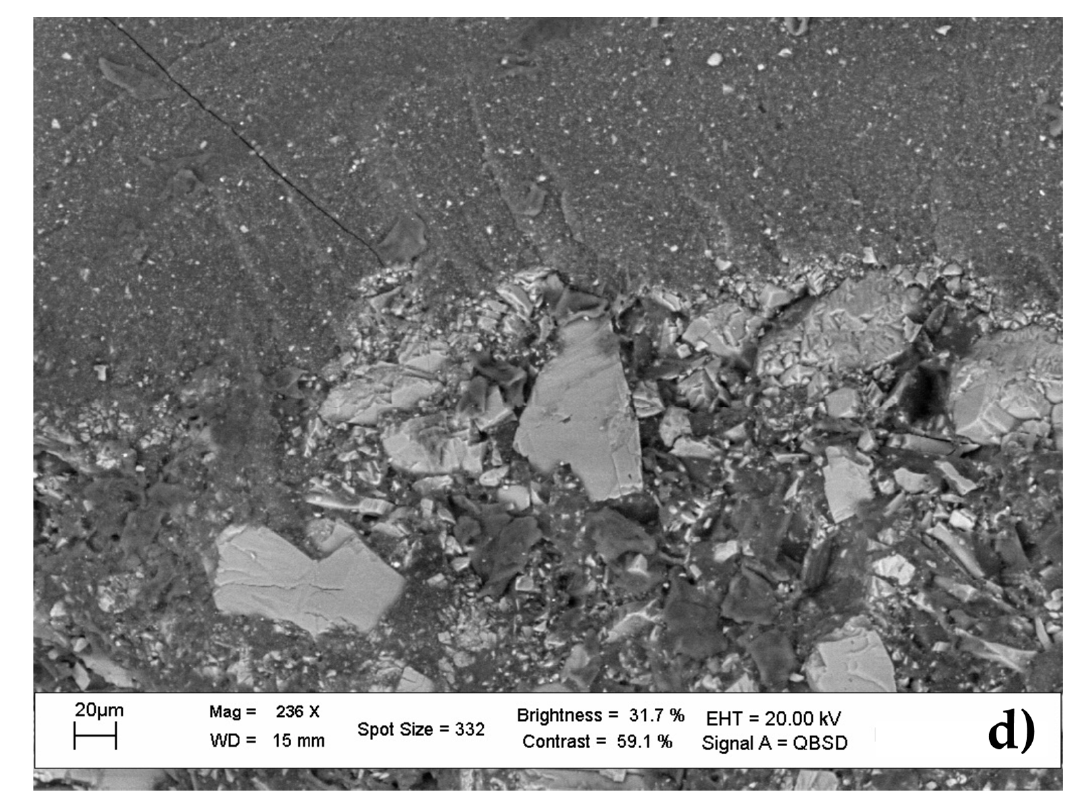
Figure 2. XRF spectra of different sections of a single statuette: ( a ) body, bulk material of mantle; ( b ) body mantle, cross-section, from red varnish to bulk; ( c ) helmet edge, cross-section, brown varnish to bulk; ( d ) neck section, pink varnish to bulk. Table 1. Levels (as %) of heavy metals determined by X-ray EDS in different parts of a sample, specifically a